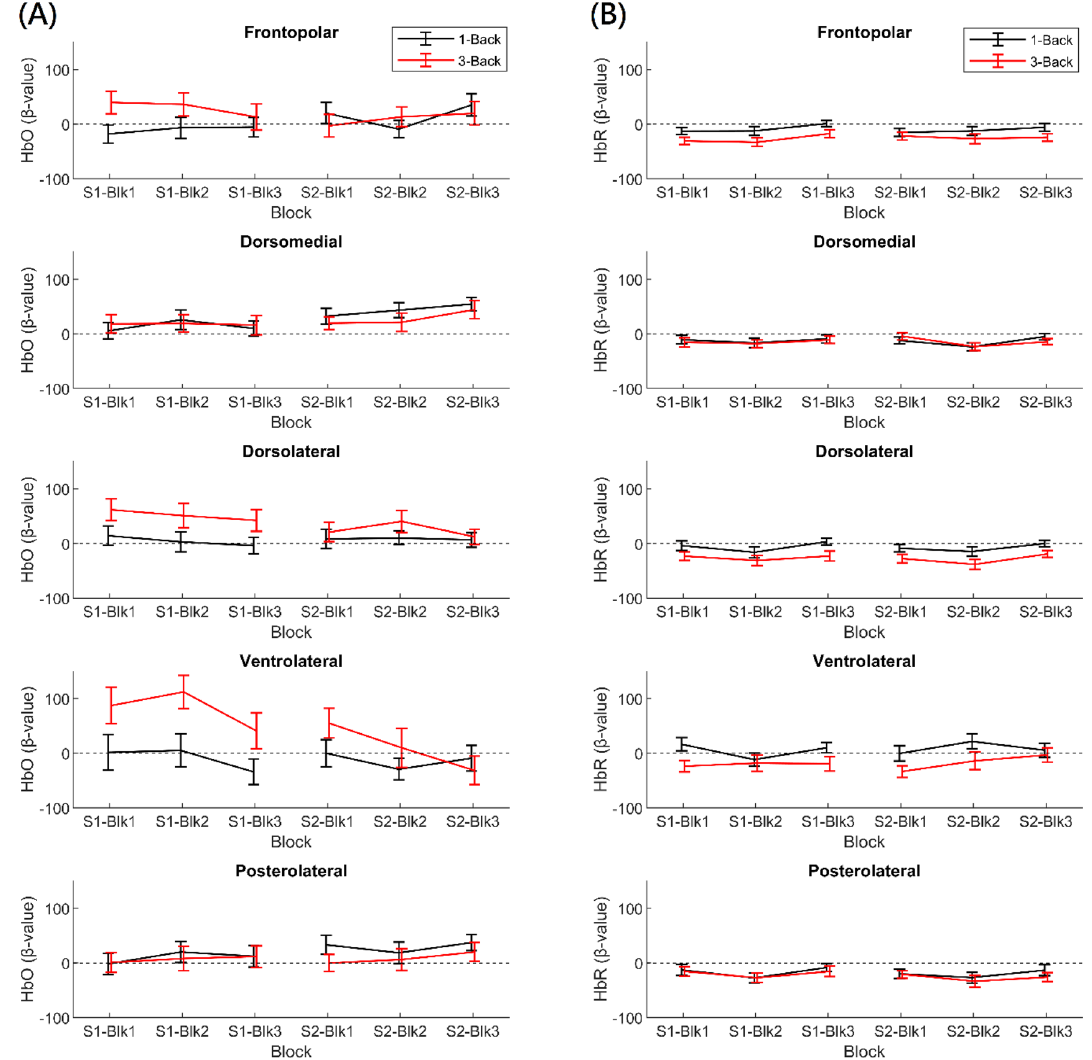
Figure 4. Time courses of changes in oxyhemoglobin (HbO) and deoxyhemoglobin (HbR) concentrations. Note Blk = Block; S1 = Session 1; S2 = Session 2. This figure illustrates within- and between-session changes in ( A ) HbO and ( B ) HbR across subregions within the frontal cortex. Error bars indicate 1 standard error ± the